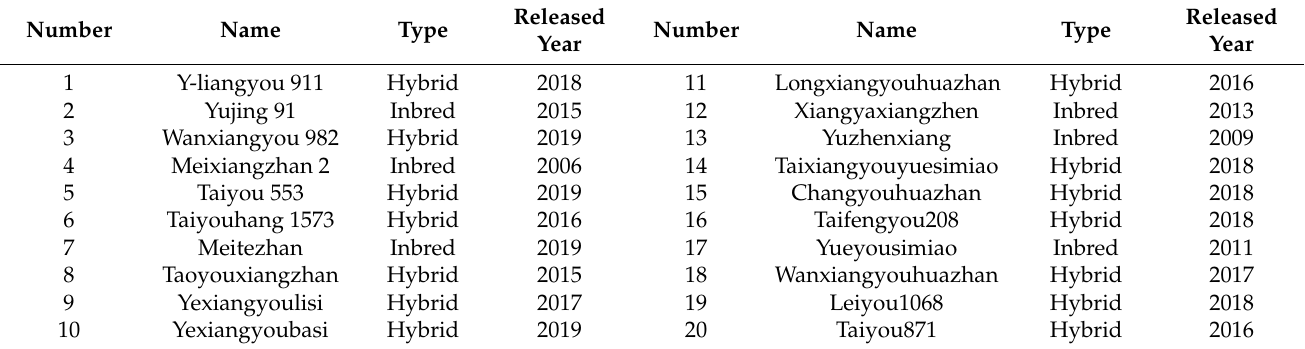
Table 1. List of twenty high-quality late indica rice